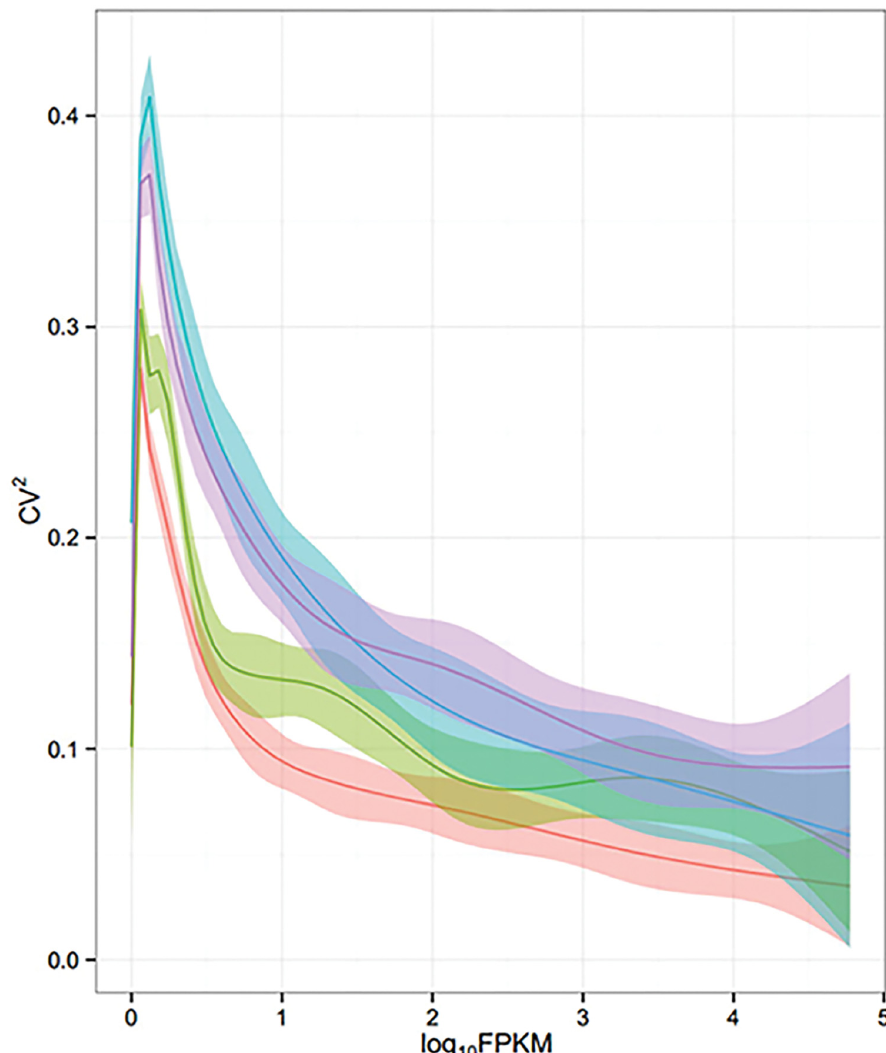
Fig 2. Biological variance within mRNA sequencing condition groups. The squared coefficient of variation (CV 2 ) was plotted against Fragments Per Kilobase of exon per Million fragments mapped (log 10 FPKM), representing the total distribution of mRNA sequence reads for each condition group, which are depicted as follows, 5 months AL (coral), 5 months CR (green), 15 months AL (blue), and 15 months CR